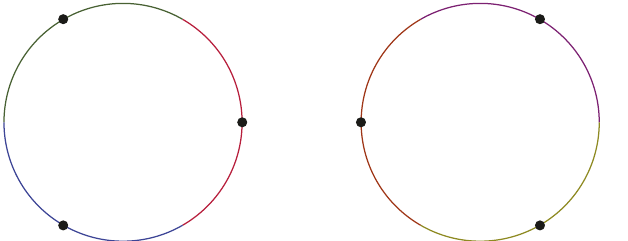
Figure 1: The figureshows attractorsdescribed by Theorem 2 and their respectiveattractionbasins for system (7). Attractorswith 0 < 𝜅 < 2/3 are the associated electoral preferences. Attractors with −2/3 < 𝜅 < 0 , also called antioptions, are completely opposite to existing options. Agents attracted to one antioption radically refuse the one option remaining half trusting to the other